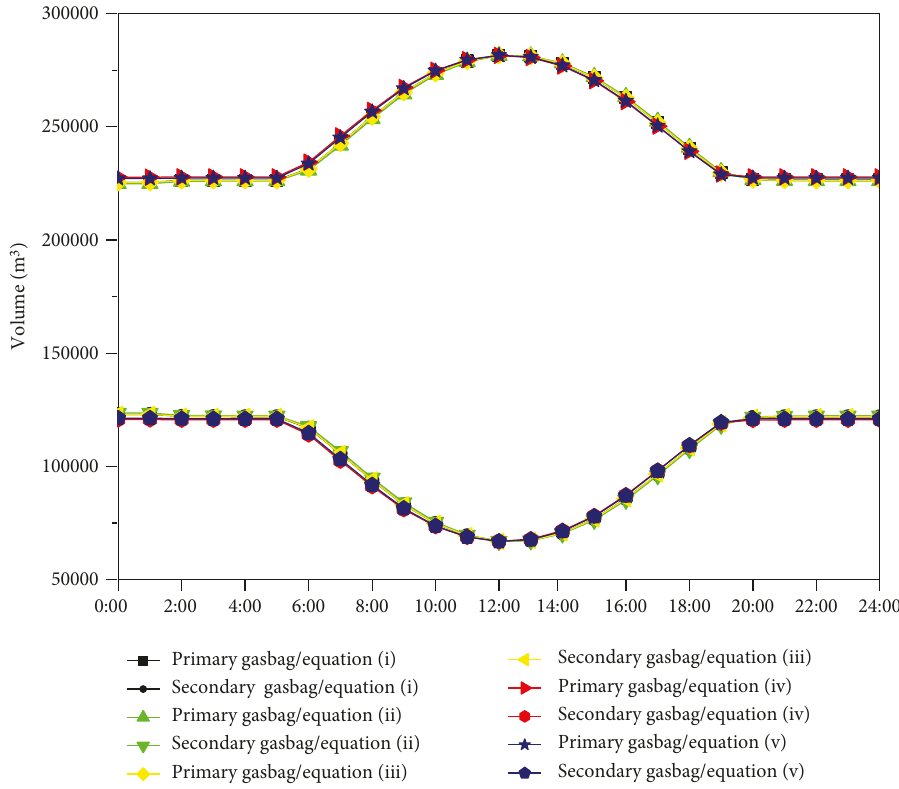
Figure 5: Helium gasbag volume changes calculated by di ff erent natural convection equations.